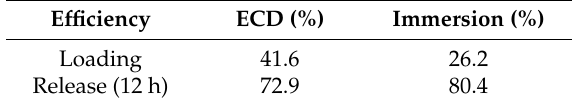
Figure 5. Viabilities of MG-63 cells cultured on treated Ti samples. The cell proliferation rate increased significantly with Ti-0.8 V, Ti-1.2 V, and Ti-1.6 V.